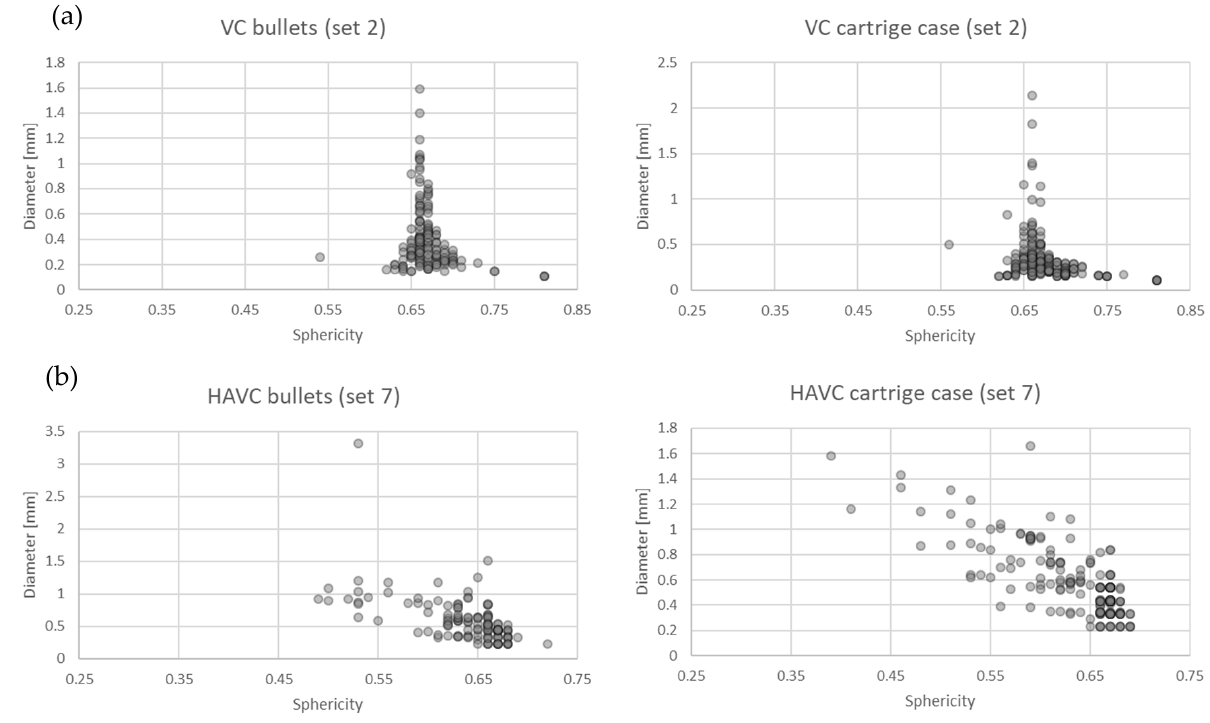
Figure 6. Shape and dimensions of the pores in specimens from series ( a ) 2 (VC) and ( b ) 7 (HAVC).